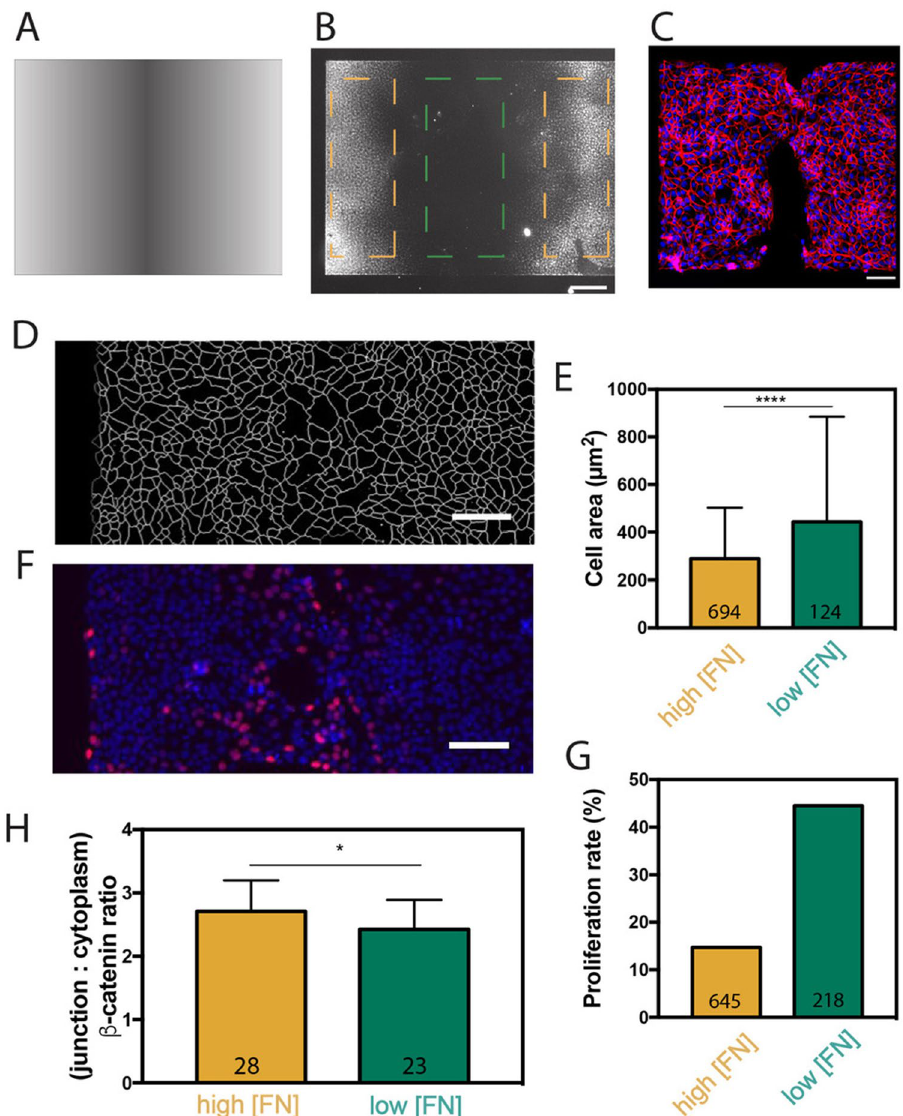
Figure 4. The closure of an epithelial tissue in haptotactic conditions does not depend on the geometry of the gradient. ( A ) Photopattern used to create a linear fibronectin gradient. ( B ) Zoomed picture of the linear FN gradient labelled with rhodamine. The picture corresponds to the half of the total pattern. The adhesive pattern can be divided into high FN zones (FN density from 384 ± 10 down to 118 ± 8 ng/cm 2 , in orange) and a low FN zone in the center (FN density from 118 ± 8 down to 32 ± 6 ng/cm 2 , in green). The scale bar represents 100 µm. ( C ) MDCK tissue grown for 18 h on a linear FN gradient. Nuclei are labelled in blue and β-catenin in red. Scale bar represents 100 µm. ( D ) Result of the segmentation of a MDCK tissue freshly healed over a FN gradient. The scale bar represents 100 µm. ( E ) Area of cells that form the tissue over the high (FN density from 384 ± 10 down to 118 ± 8 ng/cm 2 , in orange) and low (FN density from 118 ± 8 down to 32 ± 6 ng/cm 2 , in green) regions of the FN gradient. ( F ) Edu-labelling of proliferating cells (in red) just after a gap closure over a FN gradient. Nuclei are labelled in blue with DAPI. The scale bar represents 100 µm. ( G ) Percentage of proliferating cells on low and high FN zones of a linear gradient. ( H ) Ratio of the fluorescence intensity of β-catenin in cell–cell junctions and in the cytoplasm of cells over high (FN density from 384 ± 10 down to 118 ± 8 ng/cm 2 , in orange) and low (FN density from 118 ± 8 down to 32 ± 6 ng/cm 2 , in green) FN zones of a liner